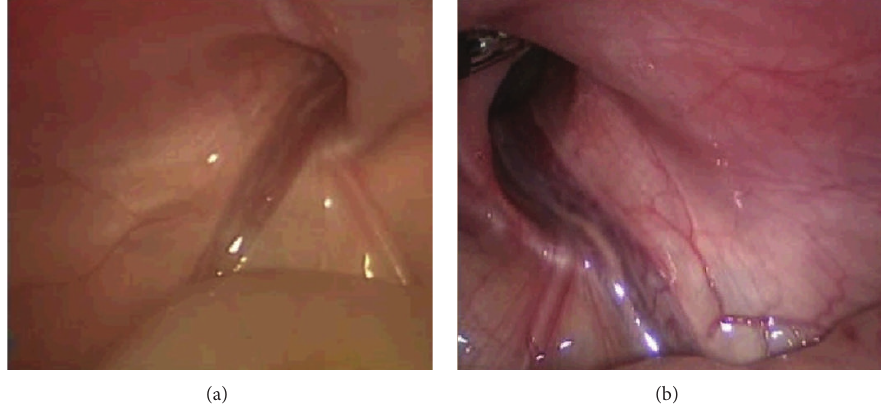
Figure 5: Laparoscopic repair of bilateral defect of the inguinal